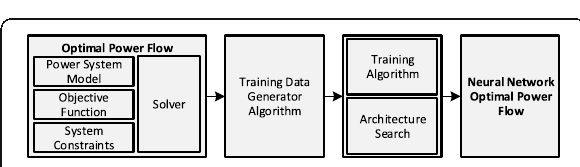
Fig. 2 (abstract PW2). Modular work-flow of the methodology for optimal ANN-based